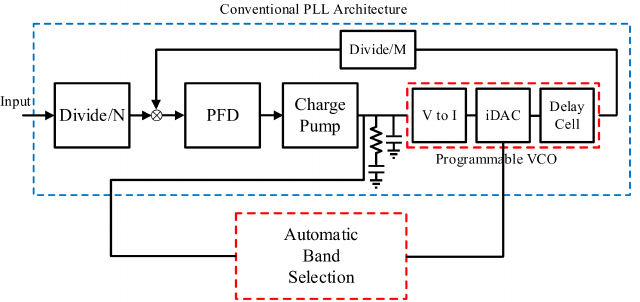
Figure 1. Block diagram of the proposed frequency